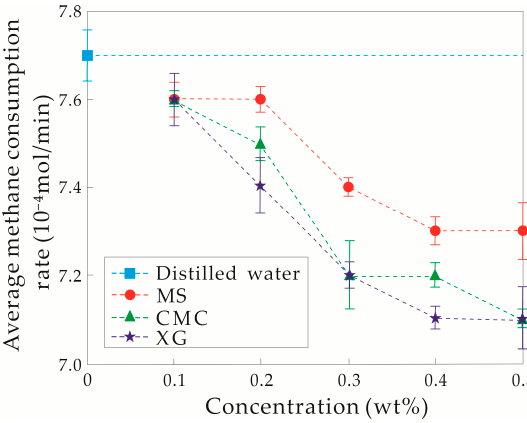
Figure 3. Hydrate formation rate changes with the concentrations of solution when the driving force is strong . MS: modified starch, CMC: carboxymethylcellulose sodium, XG: xanthan gum. strong. MS: modified starch, CMC: carboxymethylcellulose sodium, XG: xanthan